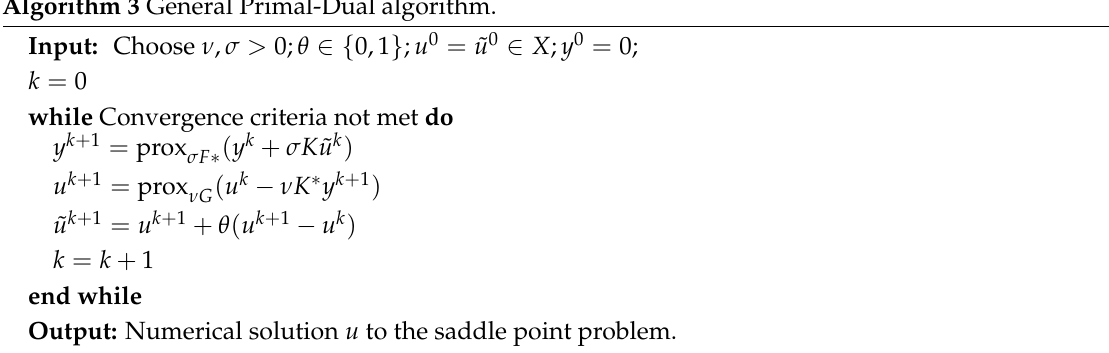
Algorithm 3 General Primal-Dual